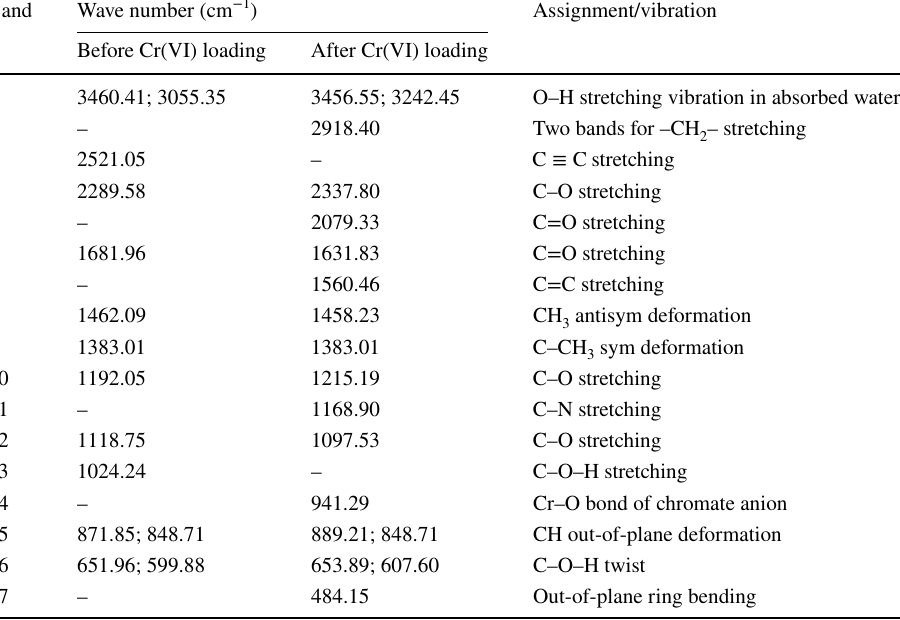
Table 3 FTIR bands of LLAC